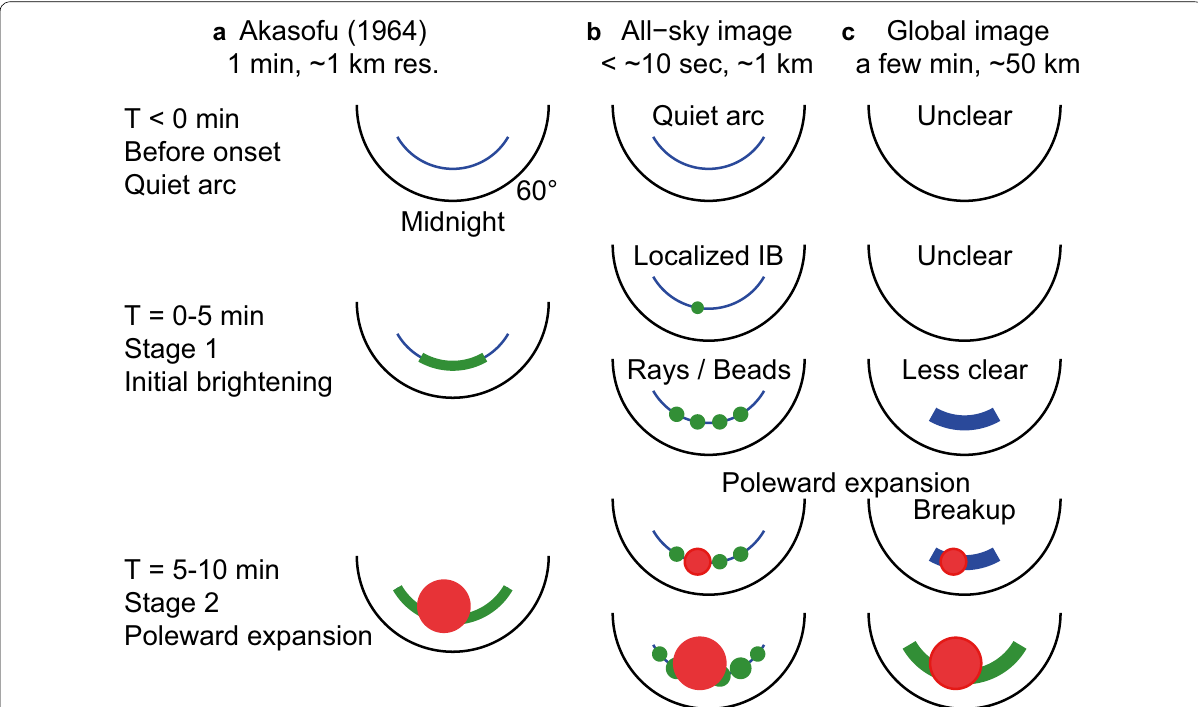
Fig. 11 Synthesis of three different views of auroral substorm onset observations: a original concept (Akasofu 1964) based on 1-min resolution ground-based all-sky images (ASIs); b high time resolution ( < ∼ 10 s ) ASIs; c satellite-based global images (resolution of a few minutes). The spatial resolution of ASIs ( ∼ 1 km ) is much better than that of global images ( ∼ 50 km ). From top to bottom, the time sequence of auroral emissions on the nightside ionosphere above 60 ◦ magnetic latitude is illustrated. The blue, green, and red colors indicate weak, moderate, and intense recorded auroral emissions, respectively. The initial brightening (IB) is longitudinally extended in a . This IB may appear as localized at the beginning followed by rapid longitudinal expansion (auroral rays or auroral beads) in b , as indicated by green circles. Red circles indicate poleward expansion (i.e., auroral breakup). A substorm onset is identified by the IB in a , and practically by the poleward expansion in c . It is undecided whether the localized IB or the poleward expansion should be used to define the substorm onset in b . Auroral brightness is significantly underemphasized in global images, presumably by area averaging when the aurora is latitudinally thinner than the spatial resolution of the